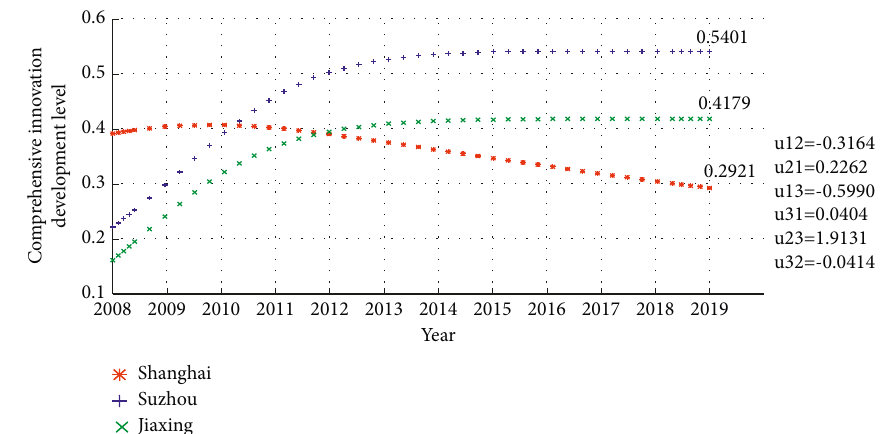
Figure 7: Evolution trend of comprehensive innovation development level under parasitic symbiosis.